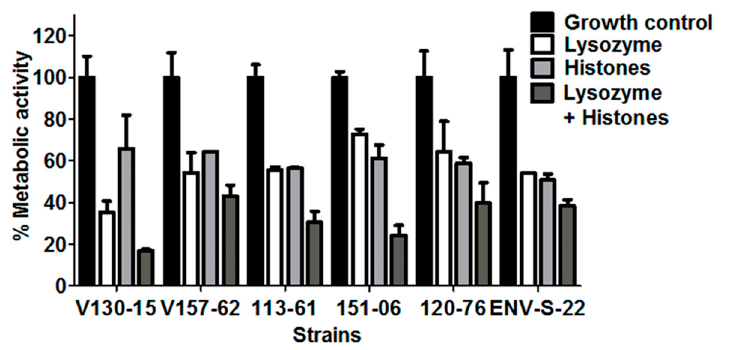
Figure 4. Antifungal activity of lysozyme, histones, and lysozyme plus histones combined against six A. fumigatus isolates. Metabolic activity of the isolates after 2 h incubation with lysozyme (20 µM), histones (50 µg/mL) or in combination is shown. In each experiment, hyphae were grown overnight in RPMI and the media was refreshed prior to adding the peptide in phosphate buffered saline. Metabolic activity was determined by XTT assay. Data was obtained in two independent experiments, each with triplicate readings; mean values ± SD are shown.